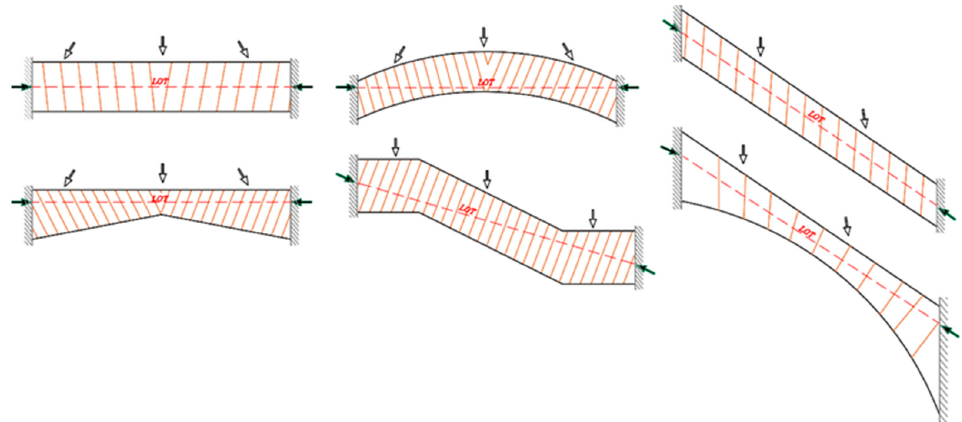
Figure 3. Non-deformable